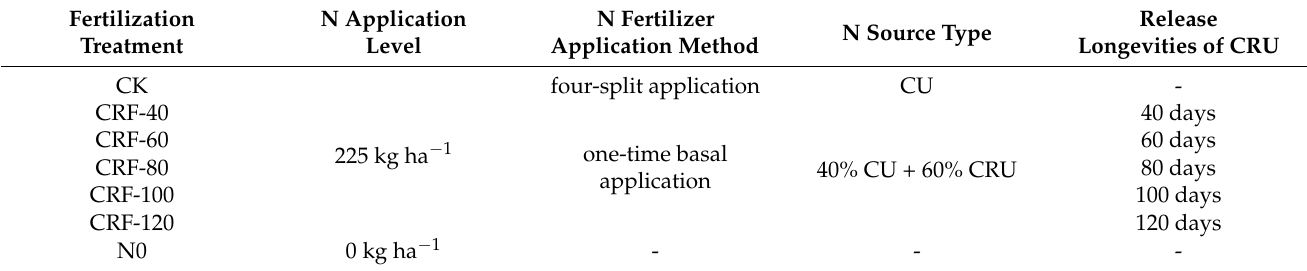
Table 2. Fertilizer information in the experimental